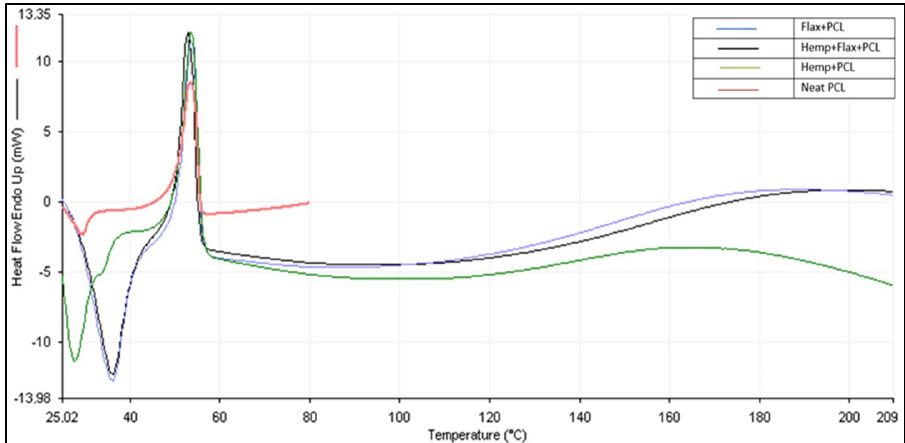
Figure 9. DSC curves representing Tg and Tm of different samples.